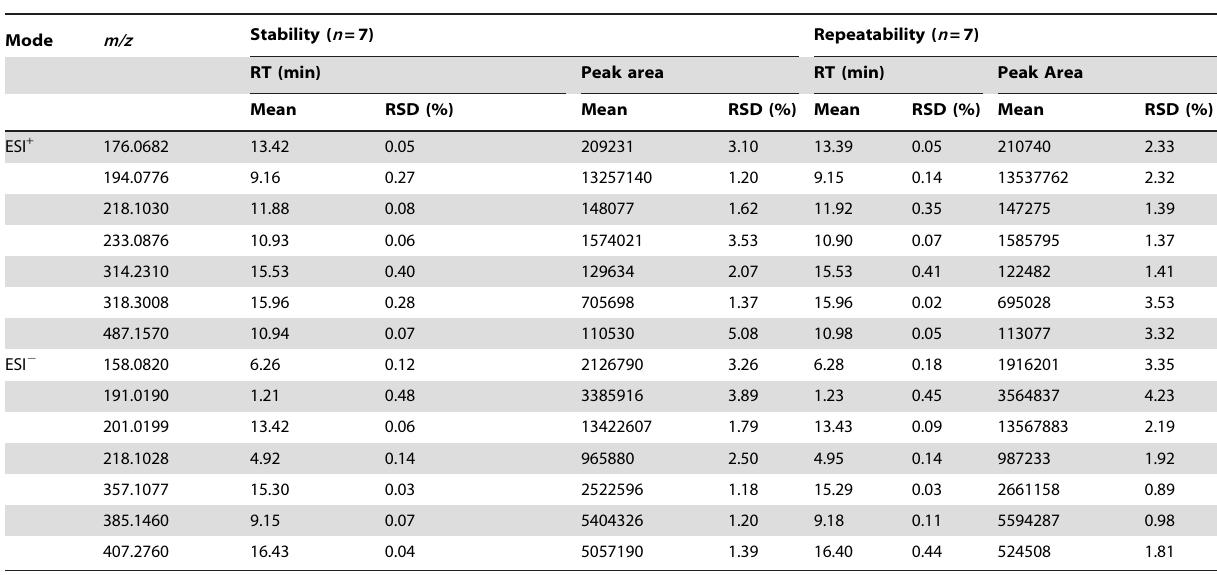
Table 3. The result of stability and repeatability of the proposed